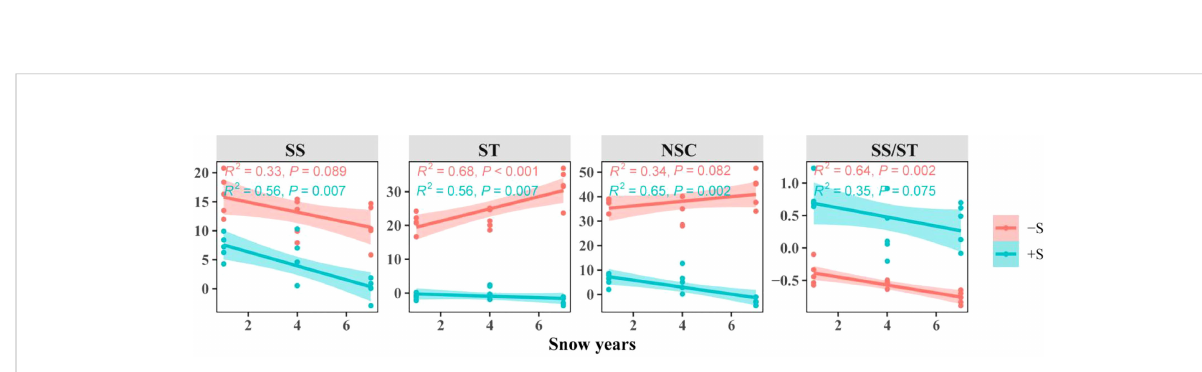
FIGURE 6 Sensitivity characteristics of Syntrichia caninervis to snow cover under different snow